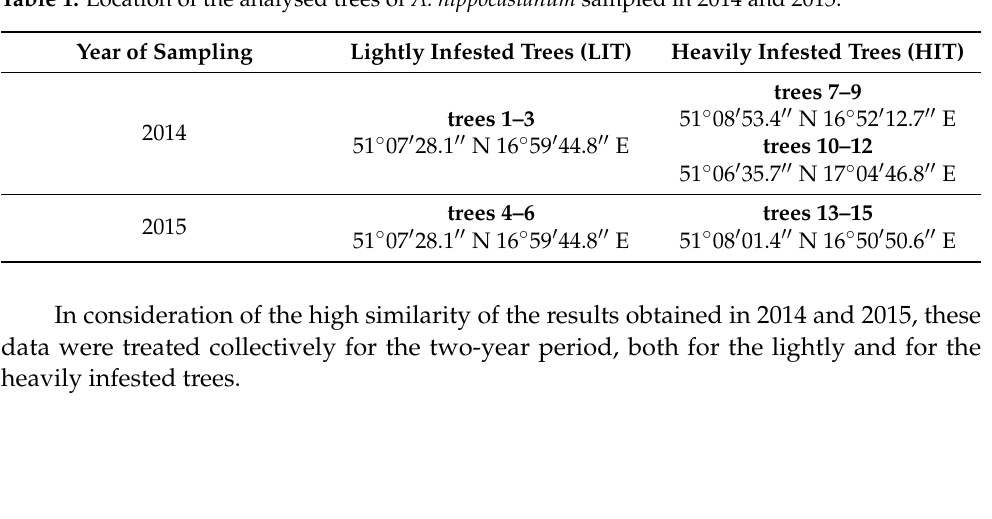
Figure 1. Map showing the location of the study area; ( a ) the city of Wrocław in a map of Europe; ( b ) magnification of Wrocław with the location of the study sites; sampling locations are marked by filled dots and analysed trees are numbered. Prepared using Google maps. Table 1. Location of the analysed trees of A. hippocastanum sampled in 2014 and